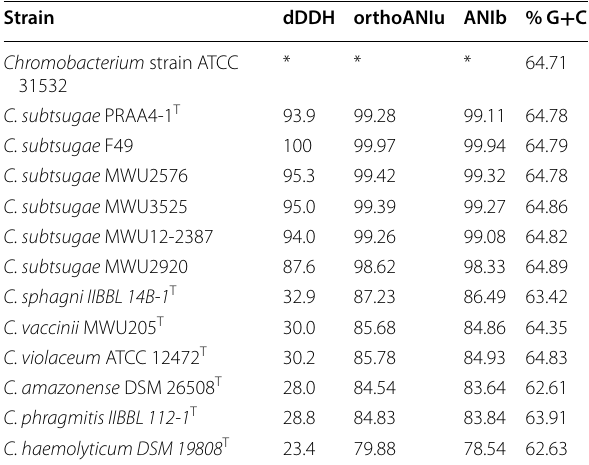
Table 1 Overall genome relatedness indices (OGRI) comparisons of Chromobacterium strain ATCC 31532 with other Chromobacterium spp. Strain dDDH orthoANIu ANIb % G Chromobacterium strain ATCC 31532